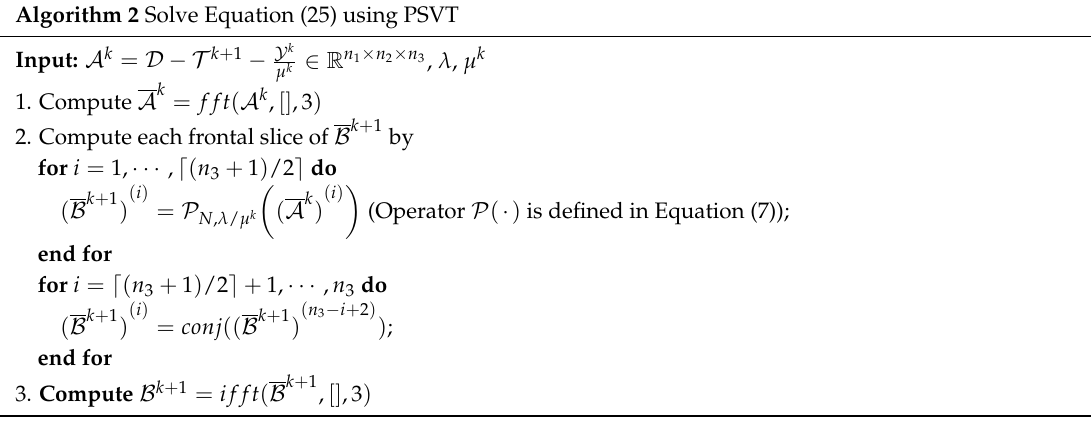
Algorithm 2 Solve Equation (25) using PSVT